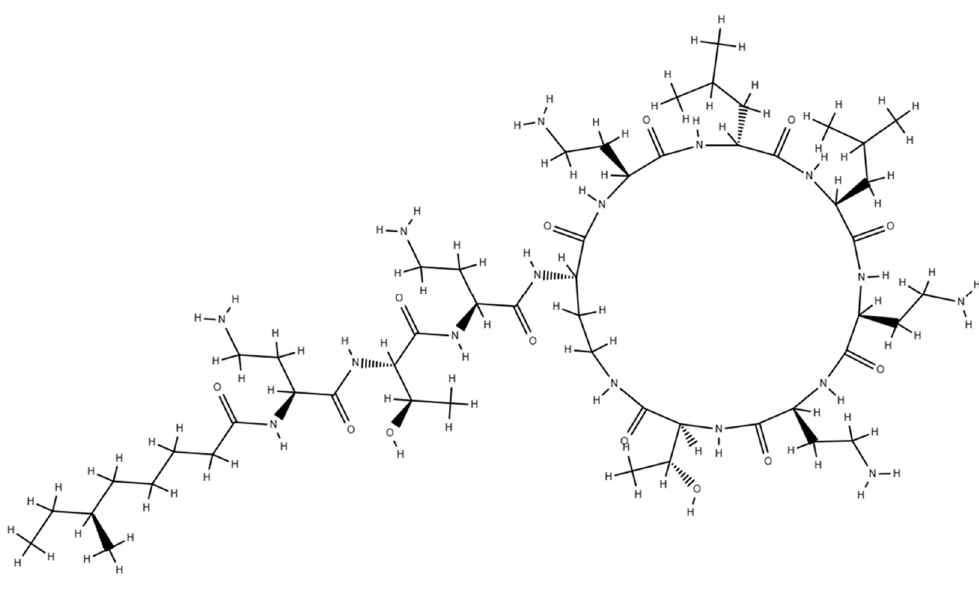
Figure 1. Chemical structure of colistin A (polymyixin E1). A cyclic heptapeptide with a tripeptide side chain acylated at the N-terminus by a fatty acid tail.